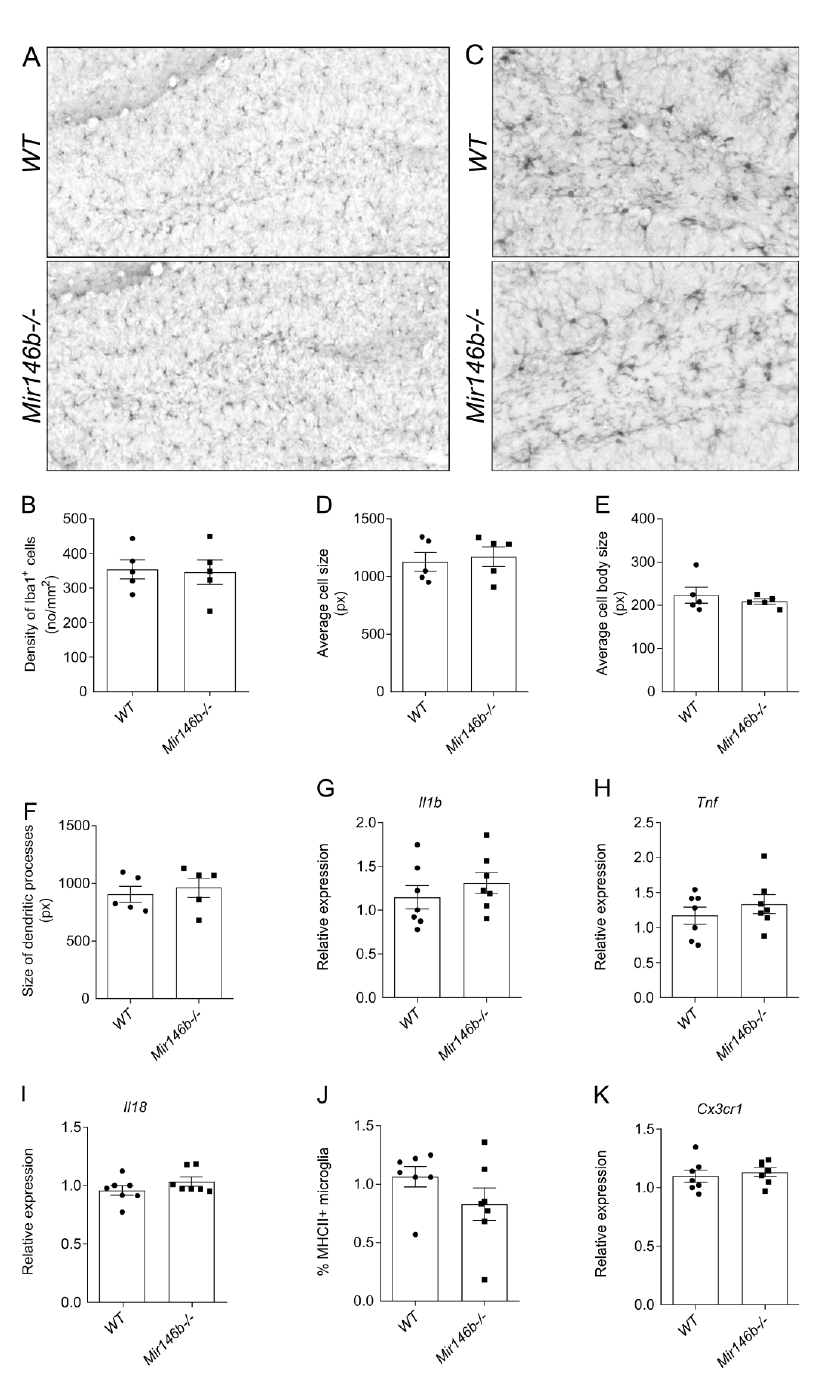
Figure 6. miR-146b deficiency does not cause microglial activation and signs of neuroinflammation in the hippocampus. ( A ) Representative images showing Iba1-positive cells at 100 × magnification. ( B ) Quantitative graphs of Iba1 counting in WT and Mir146b -/- mice. ( C ) Representative images of Iba1 immunohistochemistry for morphological analysis at 400 × magnification in the hippocampus of WT and Mir146b -/- mice. ( D ) Average cell size in pixels. ( E ) Cell body size in pixels. ( F ) Size of dendritic processes in pixels of microglial cells in the hippocampus. Number of animals = 5, Student’s t -test. ( G ) Relative mRNA expression of cytokines IL1b , ( H ) Tnf and ( I ) IL18. ( J ) Flow cytometry quantification of percentage of MHCII+ M1 type of microglia. ( K ) Relative mRNA expression of Cx3cr1 in the hippocampus of WT and Mir146b -/- mice. Number of animals = 7, Student’s t -test. Data represented as mean ± SEM,